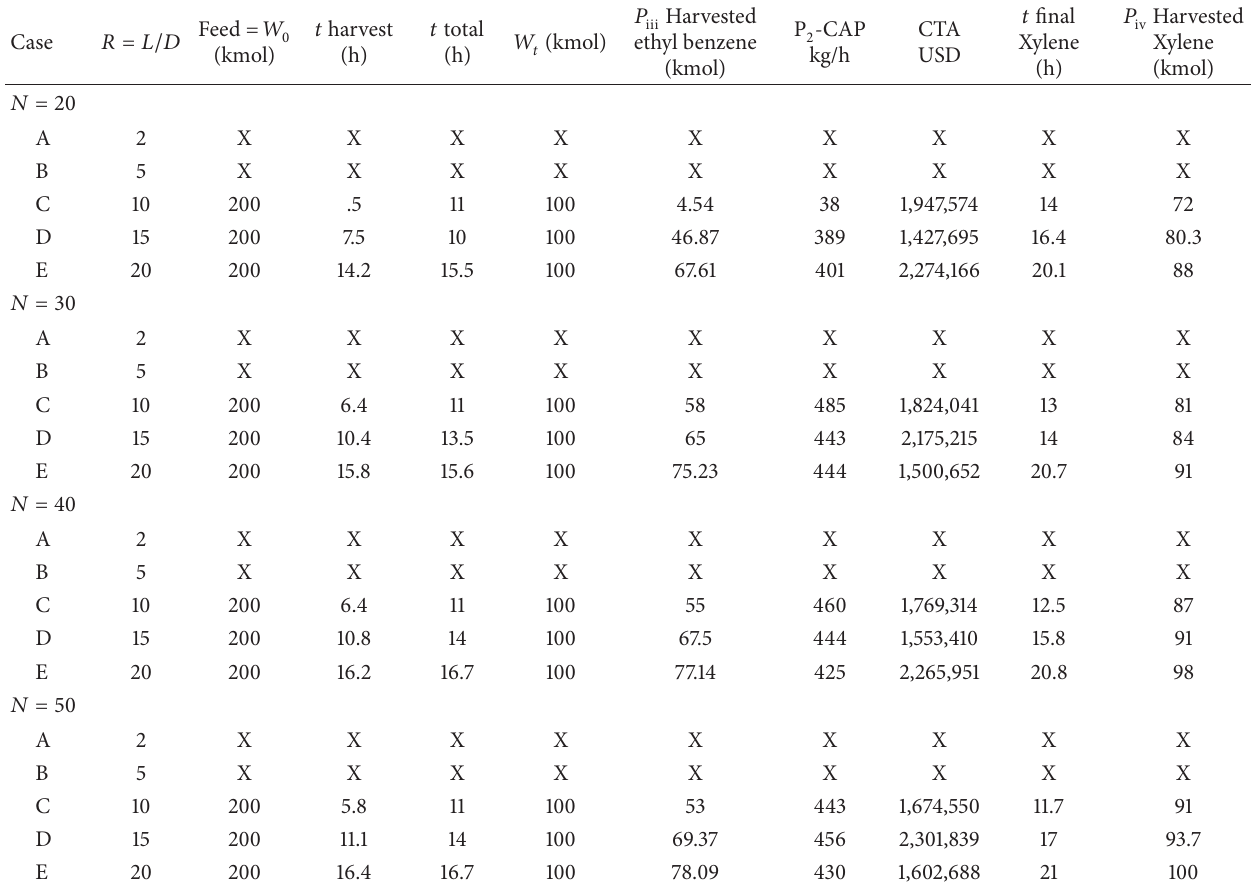
Table 6: Two components separation: ethyl benzene (iii) and xylene (iv) at constant reflux.